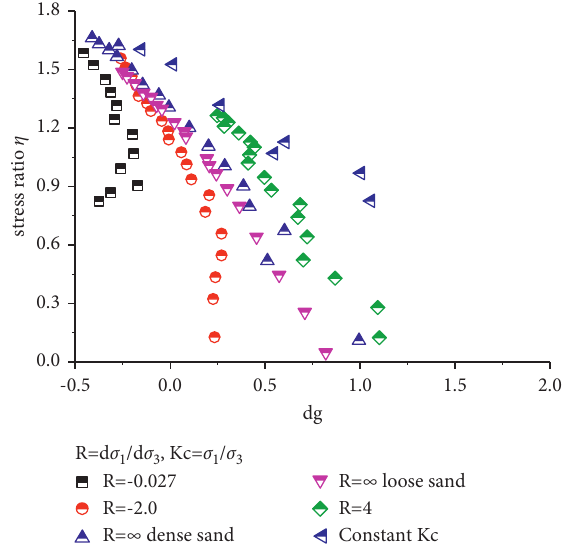
Figure 1: Stress-dilatancy of sand under different loading